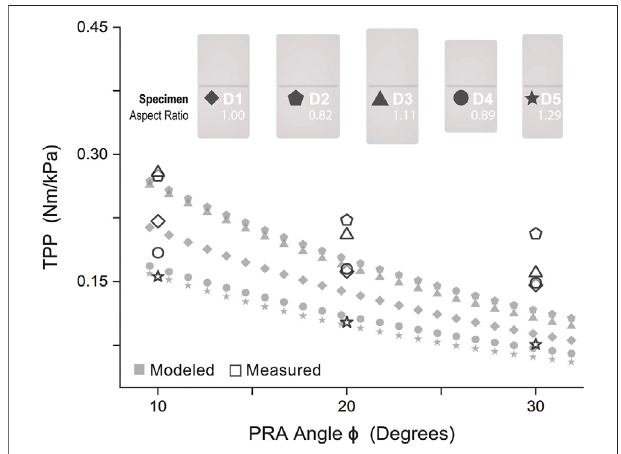
FIGURE 6 | Model Validation: Physical model compared with measured results of torque per unit pressure varied by angle for PRAs of fi ve different